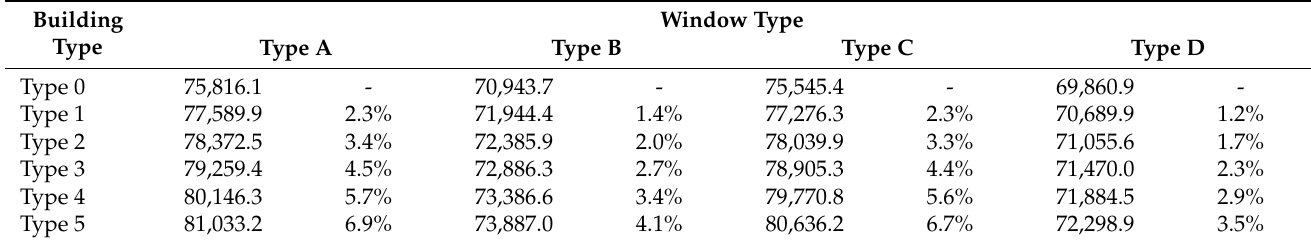
Table 8. Heat loss values for Antalya.